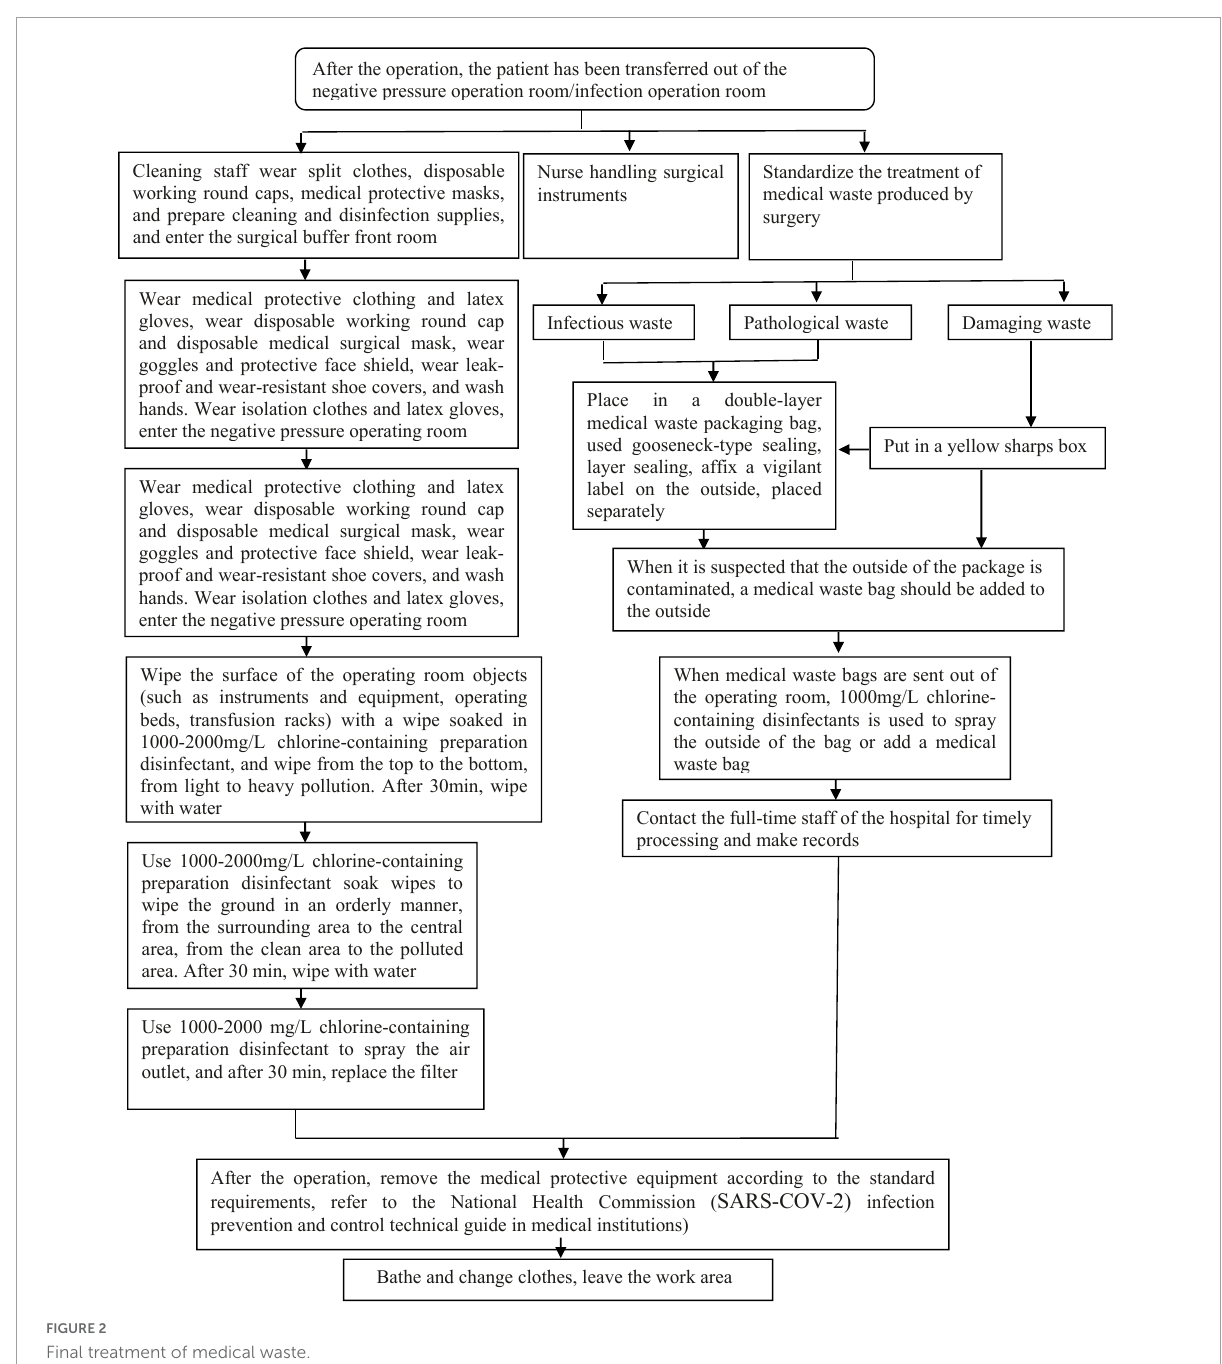
FIGURE2 Final treatment of medical waste.